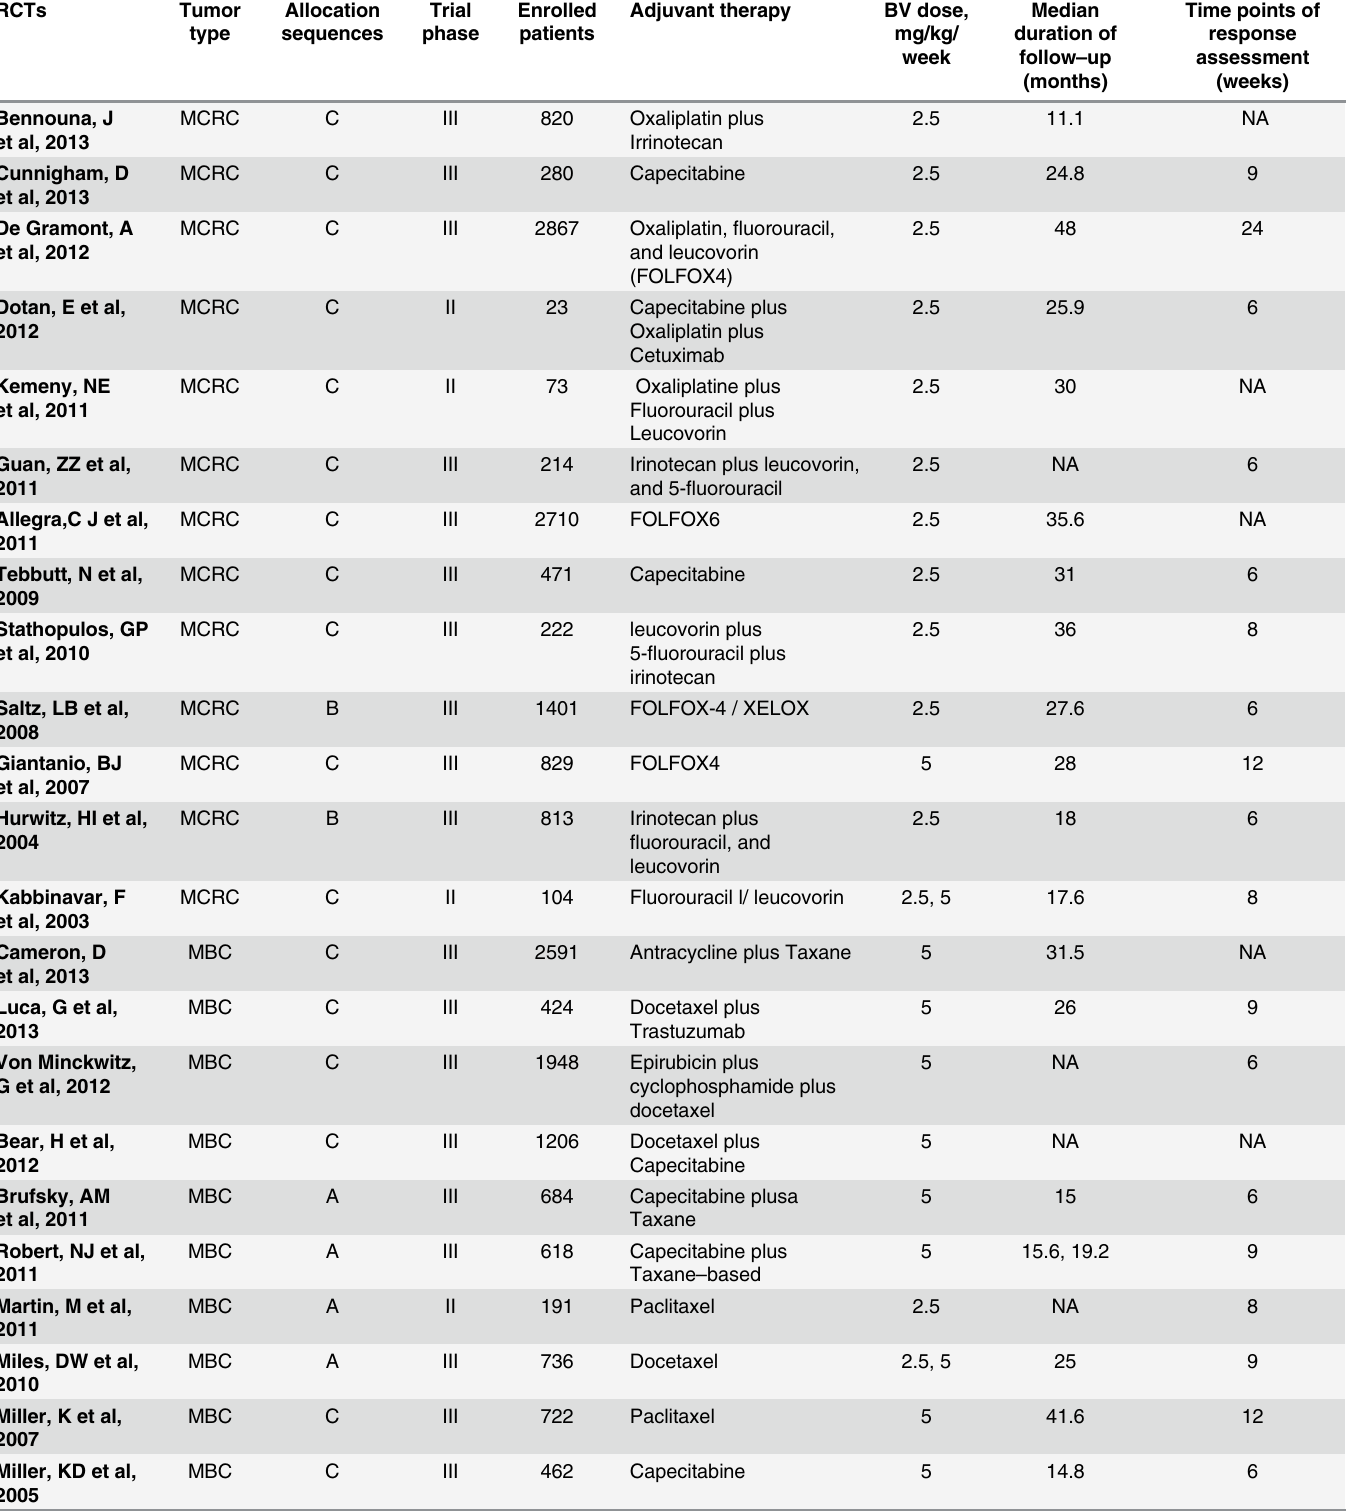
Table 1. Characteristics of trials included in the